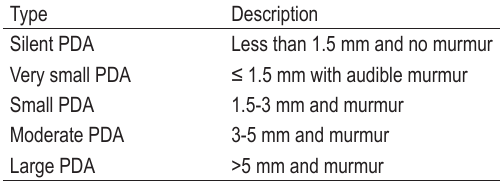
TABLE 1. Classification of PDA based on